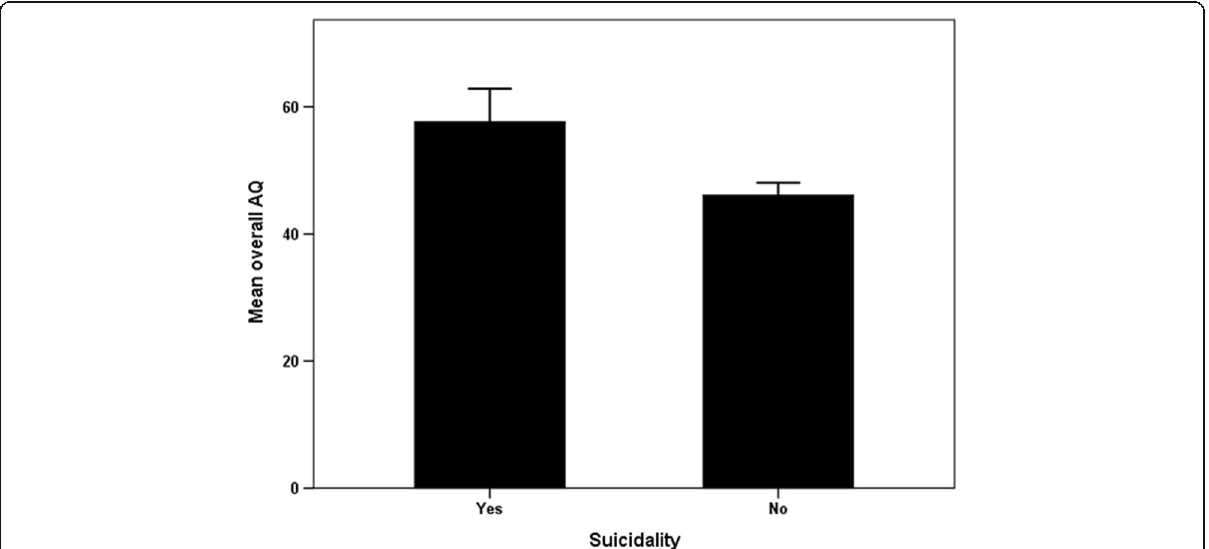
Fig. 1 Comparison of the overall AQ score between patients having suicidality ( n = 35) and those having no suicidality ( n = 109). Mean score of the overall AQ was significantly higher in patients having suicidality than the mean score of patients having no suicidality ( p < 0.001). Suicidality was determined by the MINI. Error bars represent 95% confidence intervals. AQ: Aggression Questionnaire, MINI: Mini International Neuropsychiatric Interview — Plus Version